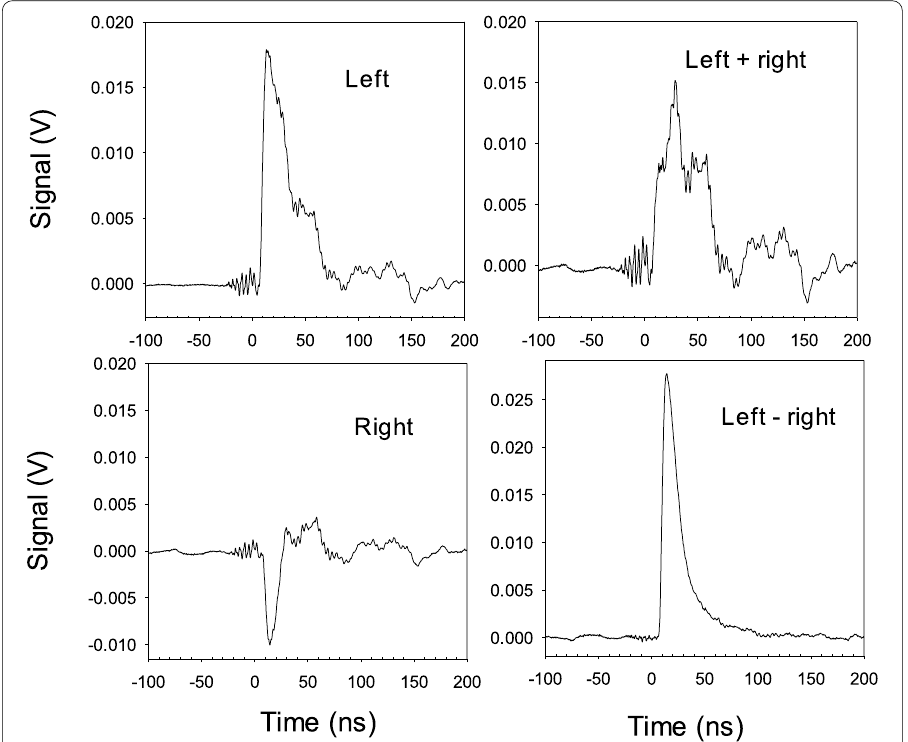
Fig. 3 Coil signal at the two ends here named left and right, with sum and difference signals. See text for analysis of the origin of the